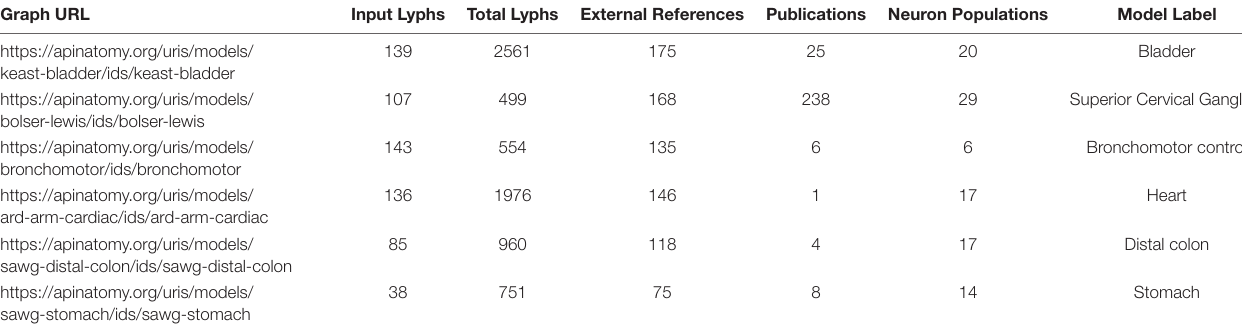
TABLE 3 | Content statistics for a sample of ApiNATOMY connectivity models in SCKAN. Graph URL Model